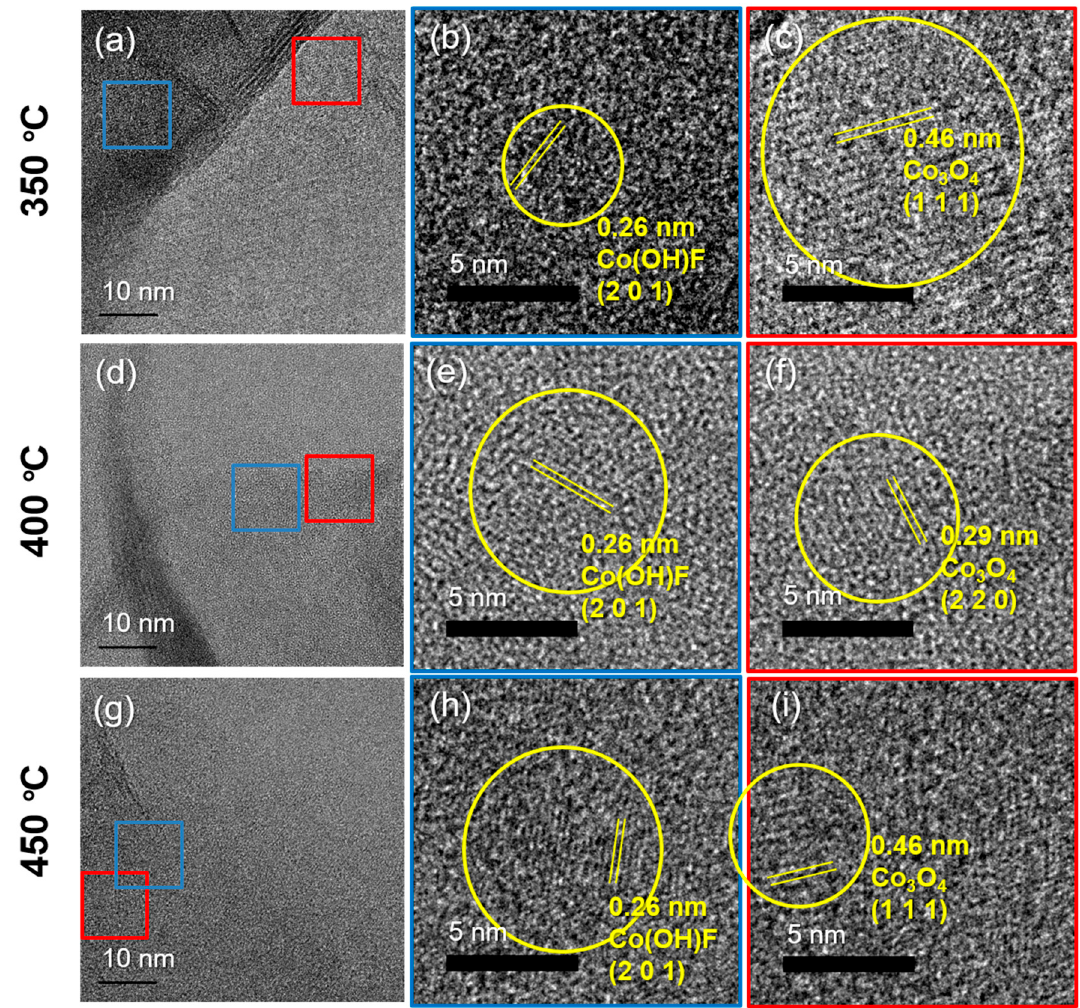
Figure 7. High-resolution TEM images of the Co(OH) x F 2 − x nanosheets annealed at ( a – c ) 350, ( d – f )